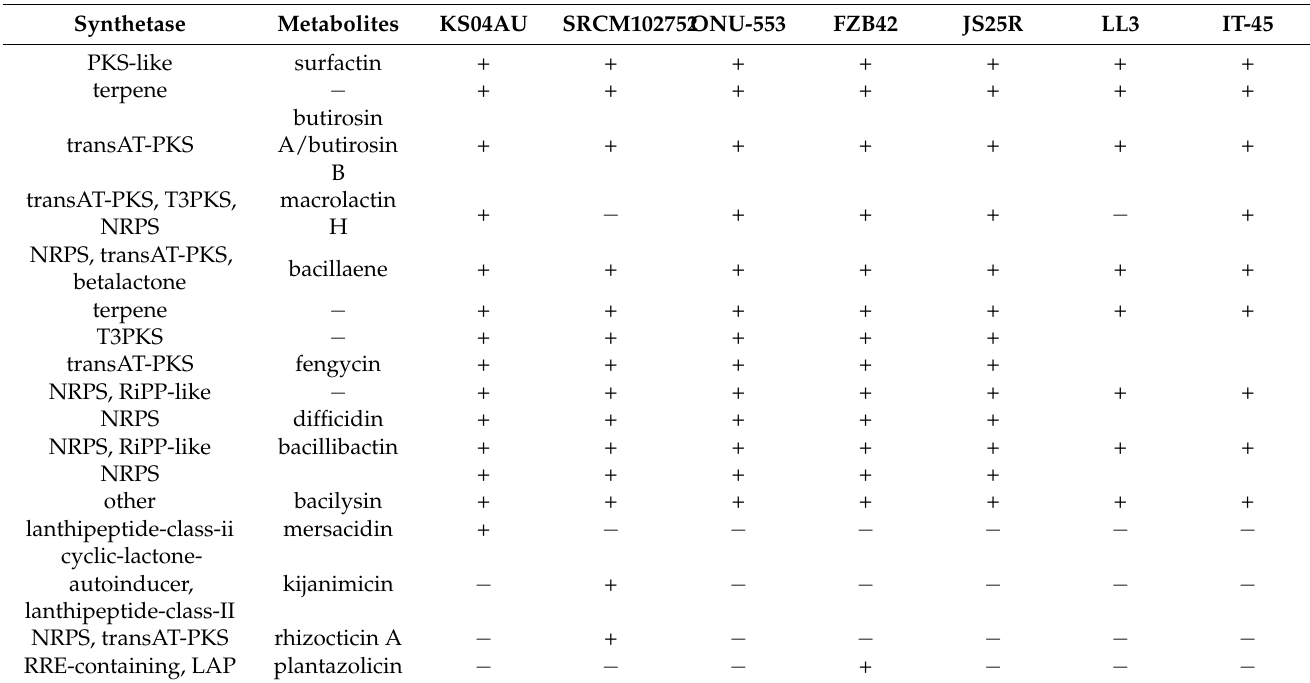
Table 7. Comparative analysis of secondary metabolite clusters of B. velezensis KS04AU with closest- related strains.